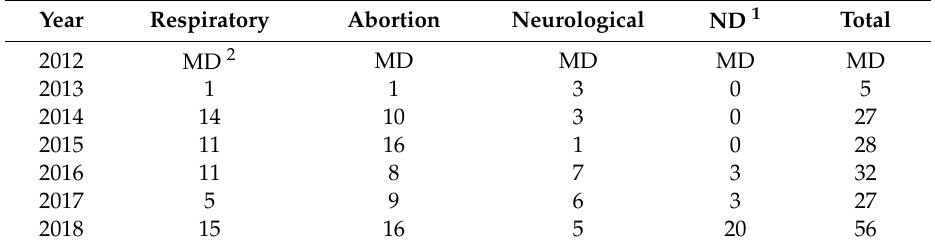
Table 1. Number of individual outbreaks of equine herpesvirus 1 (EHV-1) reported to R é